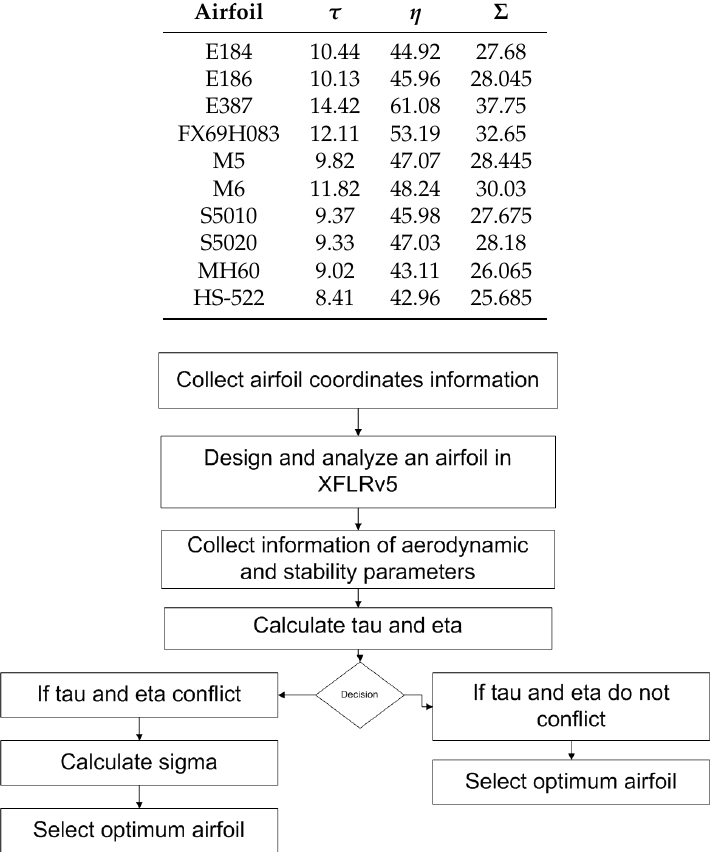
Table 2. τ , η , and Σ values for ten reflexed airfoils. The table shows Eppler-387 has best overall performance in terms of τ , η , and Σ .